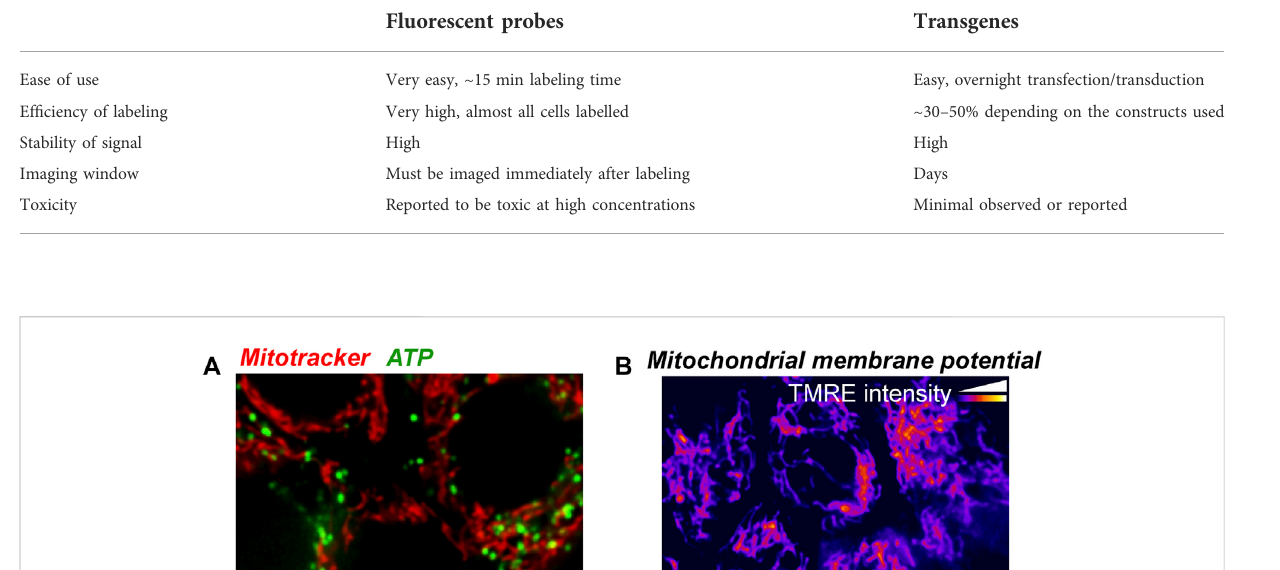
TABLE 1 Tools to visualize mitochondria in polarized RPE monolayers.